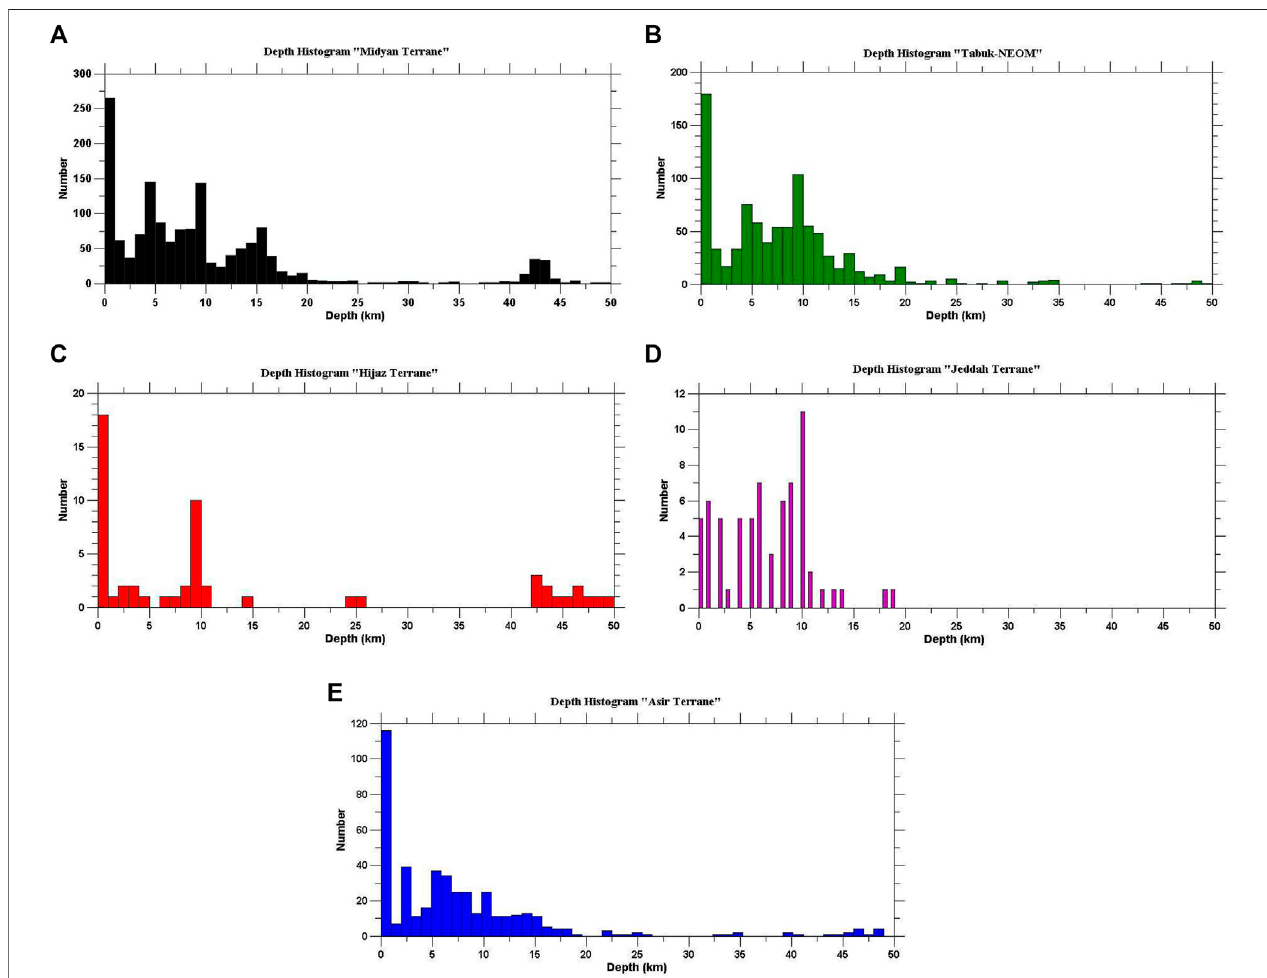
FIGURE 10 | (A – E) Depth histograms for the studied regions as represented by the color legend.